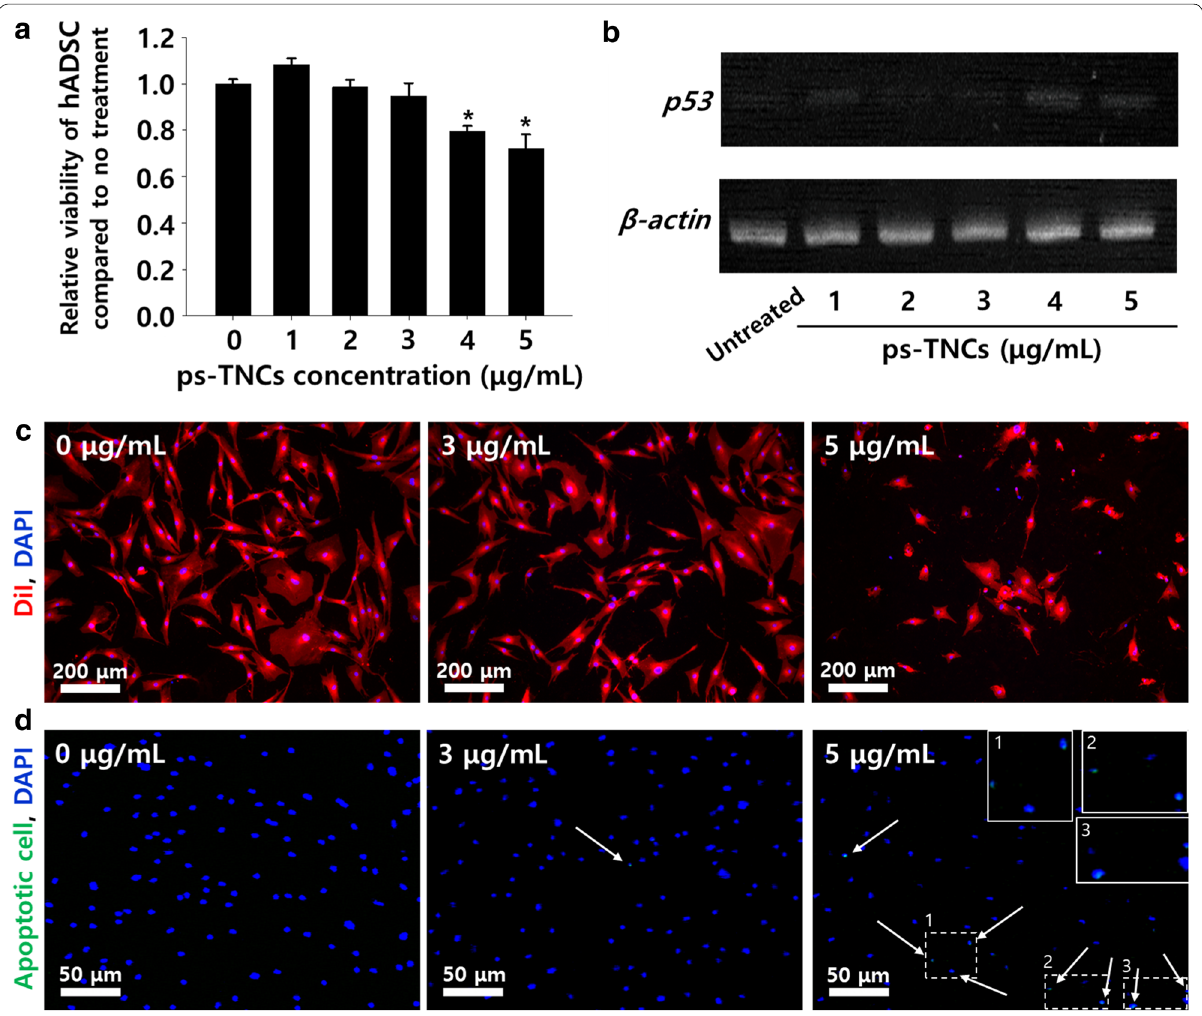
Fig. 3 Optimizing the concentration of ps‑TNCs for hADSC treatment. a Cell viability of hADSCs treated with various concentration of ps‑TNCs (n 4, * p < 0.05 compared to the untreated group). b Concentration‑dependent pro‑apoptotic mRNA ( p53 ) expression in hADSCs. c DiI staining of = hADSCs treated with ps‑TNCs (red, cellular membrane). d TUNEL assay of ps‑TNCs treated hADSCs (blue: nucleus, green: apoptotic